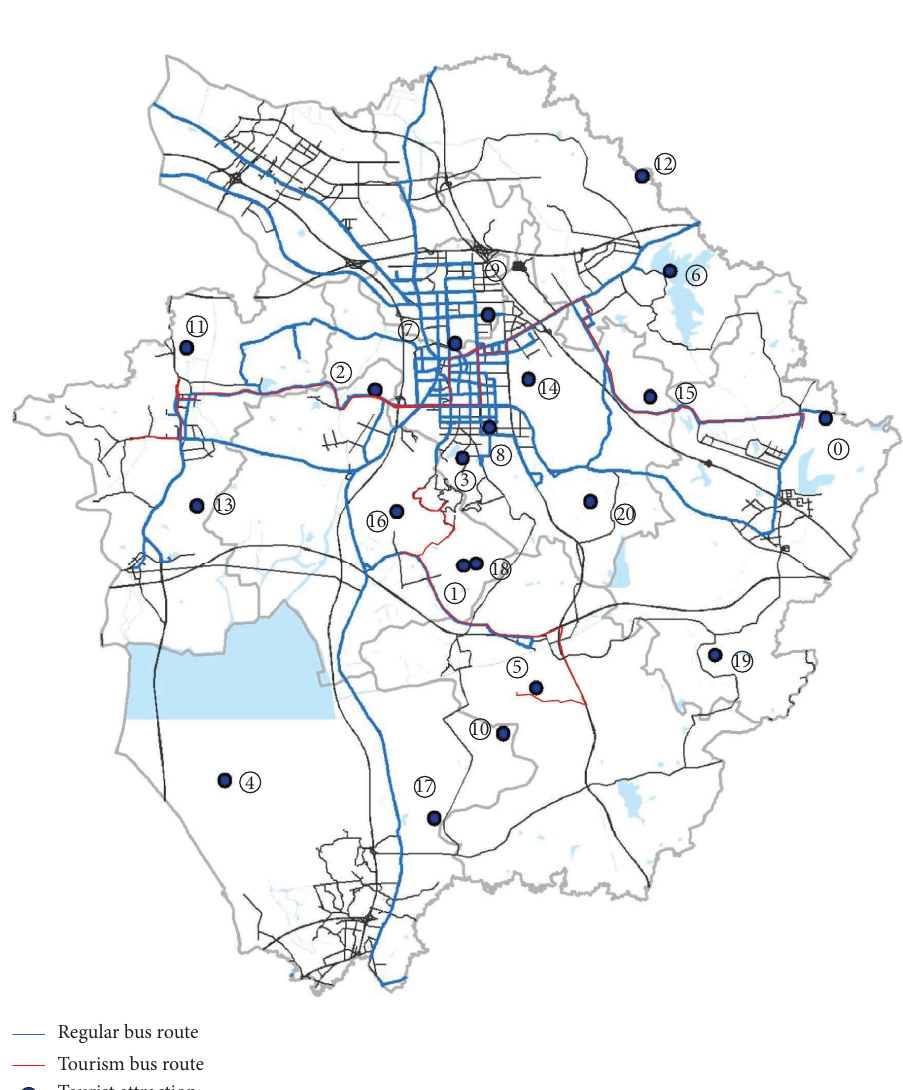
Figure 3: Tourism resources and existing bus network in Lishui